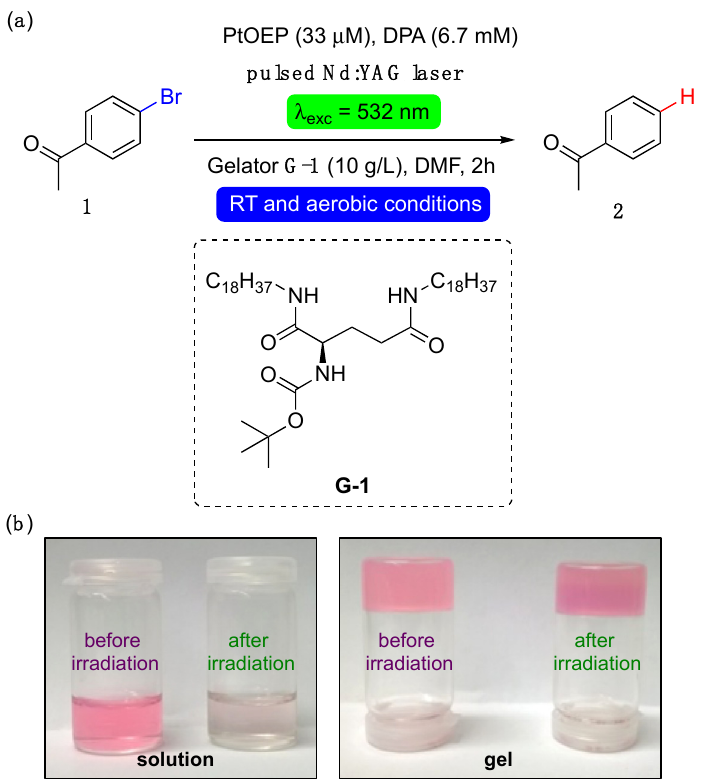
Figure 1. ( a ) Scheme of photoreduction of 4 ′ -bromoacetophenone ( 1 ) promoted by TTA-UC and performed in a supramolecular gel made of LMW gelator G-1 . ( b ) Photographs of doped solutions before and after irradiation showing decolorization caused by degradation of PtOEP ( left ) and photographs of doped gel before and after irradiation ( right ). Adapted with permission from ref. [10]. Copyright 2015 Royal Society of Chemistry.